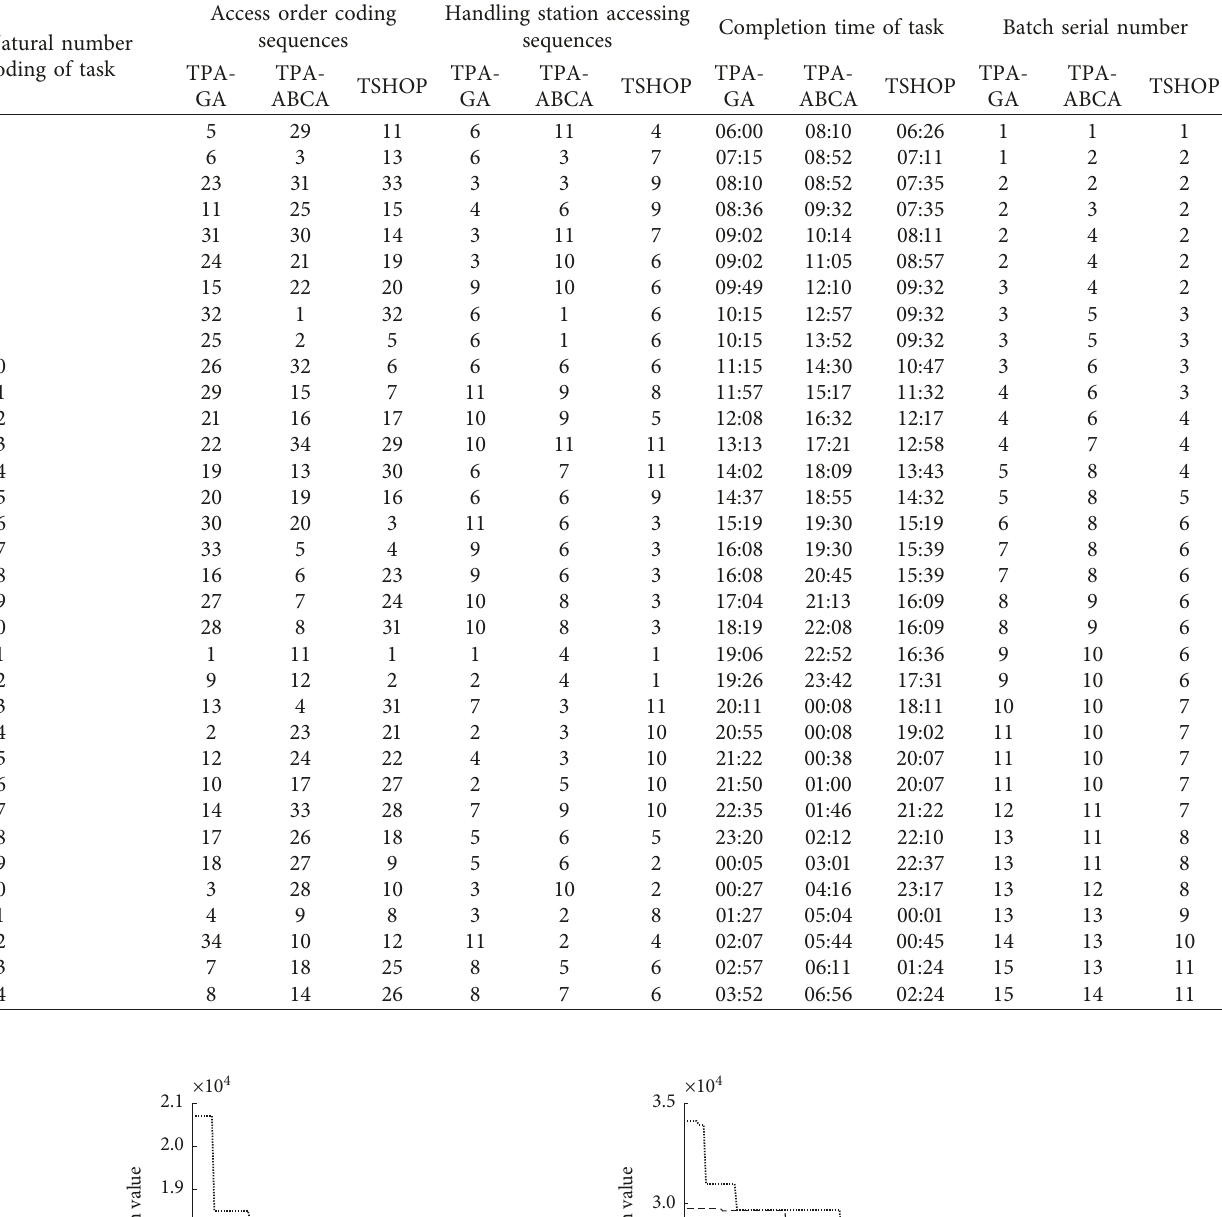
Table 11: The optimal solution for TPA-GA, TPA-ABC, and TSHOP applied to the instance with 34 item tasks. Natural number coding of